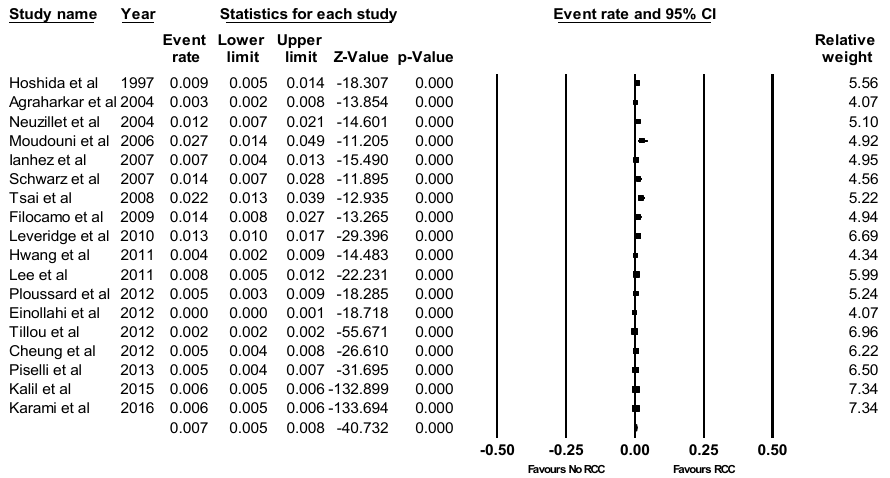
Figure 2. Forest plots of the included studies [11–20,28,29,31,32,34,35,38,39] assessing incidence rates of RCC after KTx. A diamond data marker represents the overall rate from each included study (square data marker) and 95% confidence interval.